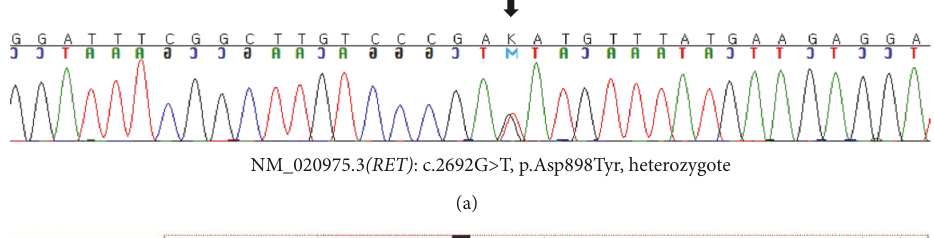
in dbSNP (rs587780810) and once in the ClinVar database (RCV000123314.1) as a variant of uncertain